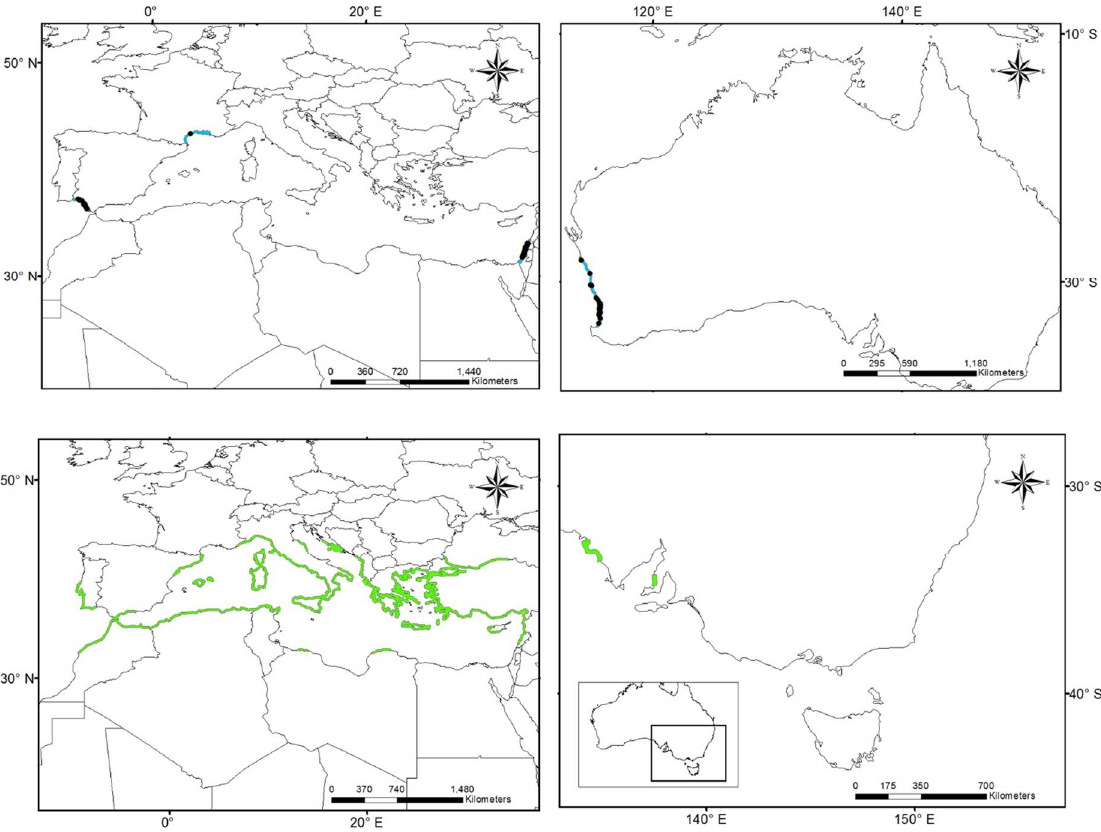
Figure A5. Training (blue) and projection (green) areas for the construction of the models corresponding to Mediterranean hot summer climates (Csa). Black dots represent occurrence records.